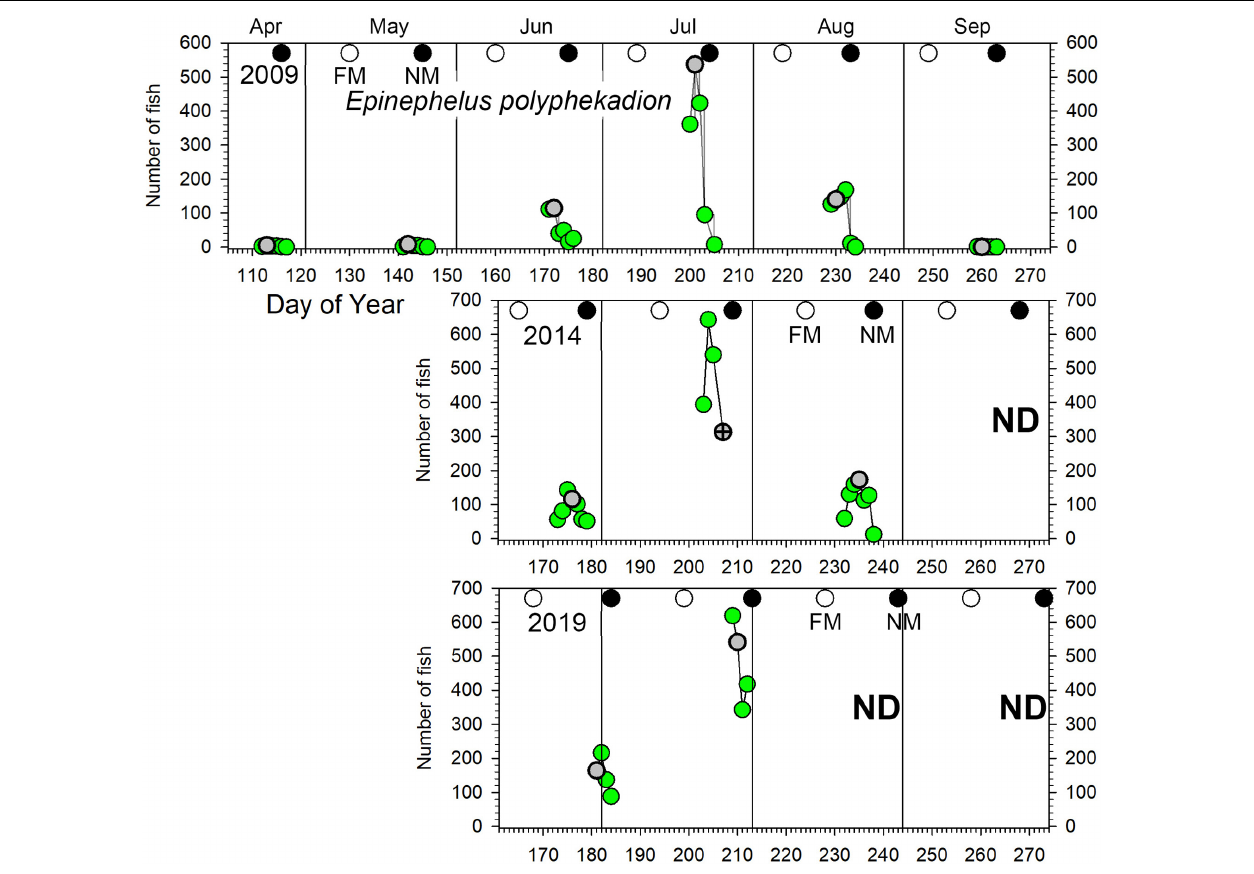
FIGURE 4 | Number of E. polyphekadion counted in UVC surveys across the Ebiil site in 2009, 2014, and 2019 for the major aggregation period by day of the year and relative to full and new moon phases. The gray circles indicate day 3 before new moon (3 BNM), except for July 2014 when poor weather cut short surveys; for this month the symbol has a cross in its center and indicates 2 days BNM. Note differences in y -axes across years. ND, no